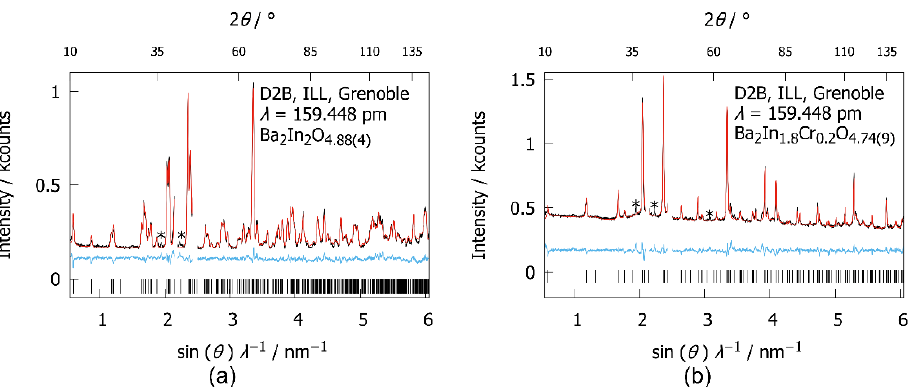
Figure 15. ( a ) Rietveld refinements of the crystal structure of Ba 2 In 2 O 4.88(4) ( Icmm , a = 6.0781(3) Å, b = 16.7335(8) Å, c = 5.9493(3) Å) at 10 K, R p = 3.31%, R wp = 4.30%; summarised data of Numor 556399–556708. ( b ) Rietveld refinements of the crystal structure of Ba 2 In 1.8 Cr 0.2 O 4.74(9) I 4 cm , a = 5.9823(2) Å, c = 16.946(1) Å, R p = 2.18%, R wp = 2.95%) at 10 K; excluded regions due to cryofurnace contribution, unassigned reflections are marked with *. Summarised data of Numor 556770–556779, DOI: